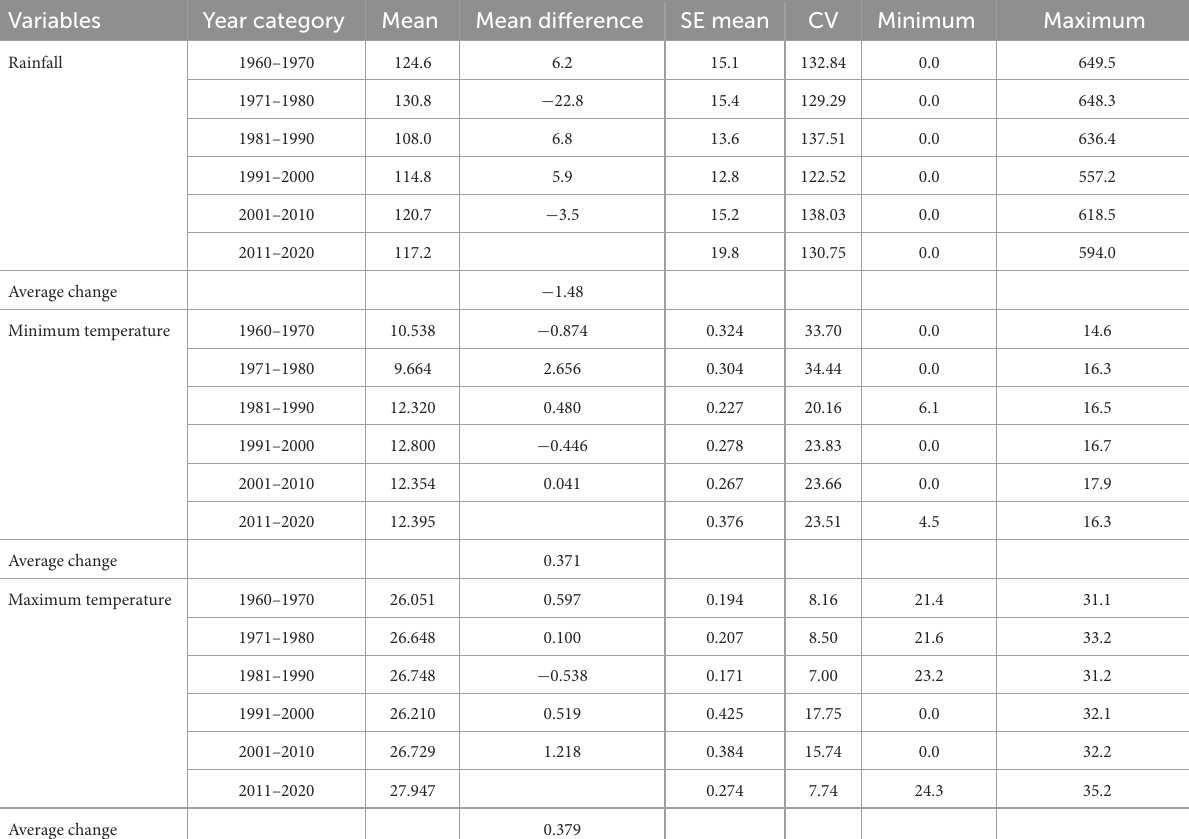
TABLE 4 Basic descriptive statistics for rainfall, minimum and maximum temperature based on decades from 1961 to 2015. Variables